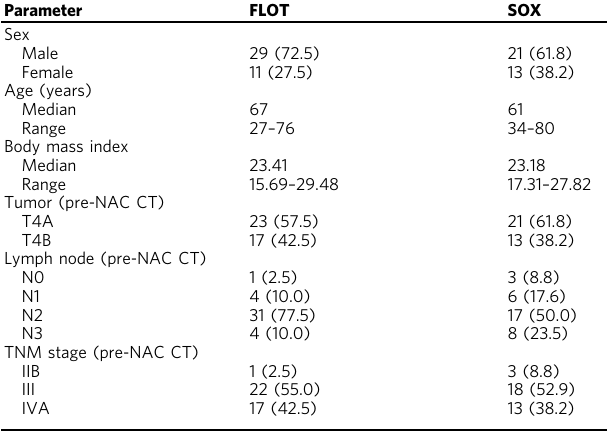
Analysis of intention-to-treat (ITT) population.